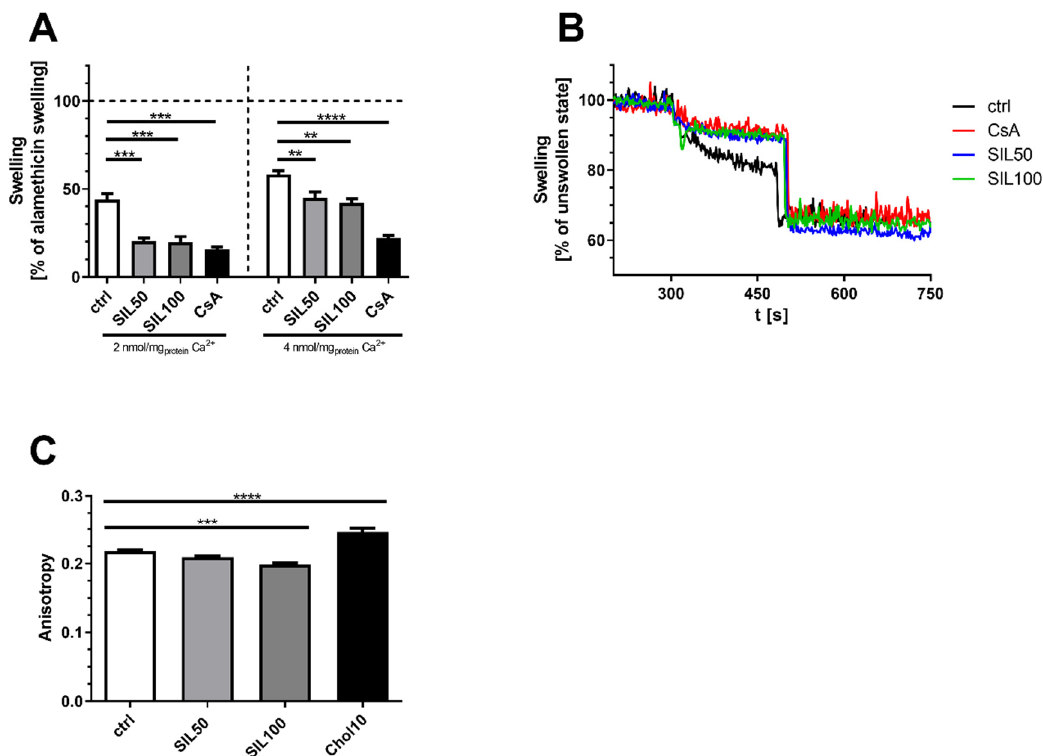
Figure 3. Mitochondrial swelling and membrane fluidity in freshly isolated mitochondria of aged NMRI mice. ( A ) Mitochondrial swelling (% of maximum alamethicin swelling). Freshly isolated mitochondria were activated by the addition of 5 mM glutamate, 5 mM malate and 4 mg/mL oligomycin. Mitochondria were treated with 50 µ M or 100 µ M SIL (SIL), control (ctrl) or Cyclosporin A as negative control and an additional 20 µ M ADP. The swelling was induced via the addition of 2 nmol/mg Protein Ca 2+ or in an identical setup with 4 nmol/mg Protein Ca 2+ . Protein content of samples was determined via the BCA method. The addition of 8.5 µ g/mL alamethicin at the end resulted in maximum swelling of mitochondria. ( B ) Visual representation of an exemplary experiment with 2 nmol/mg Protein Ca 2+ . Calcium was added after 300 s and alamethicin after 500 s. ( C ) Mitochondrial membrane fluidity measured as anisotropy in intact brain mitochondria from aged NMRI mice. Anisotropy was measured using TMA-DPH as marker. Mitochondria were incubated with SIL (SIL) in different concentrations (50 µ M and 100 µ M) and measured against control cells treated with DMSO (ctrl). As positive control, 10 µM Cholesterol (Chol10) was used as it is known to reduce membrane fluidity. Displayed are means ± SEM. n = 8–10. Statistical significance was tested in all experiments via one-way ANOVA and Tukey’s post-hoc test. Statistical analysis in A was determined for each Ca 2+ concentration separately. (**** p < 0.0001, *** p < 0.001, ** p < 0.01).